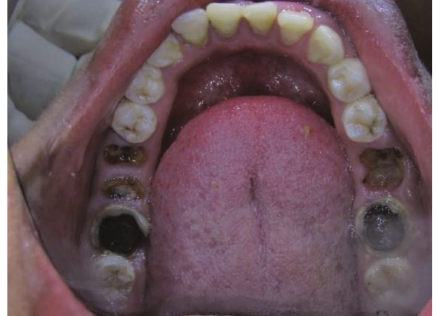
Figure 16: Case 3: shovel-shaped mandibular canines.